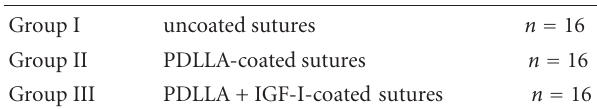
Table 2: Experimental